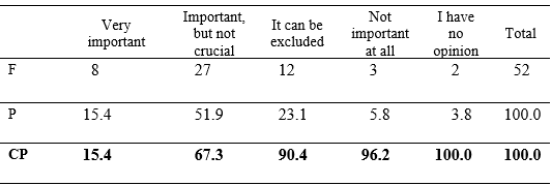
Table 18. Student’s attitudes about the